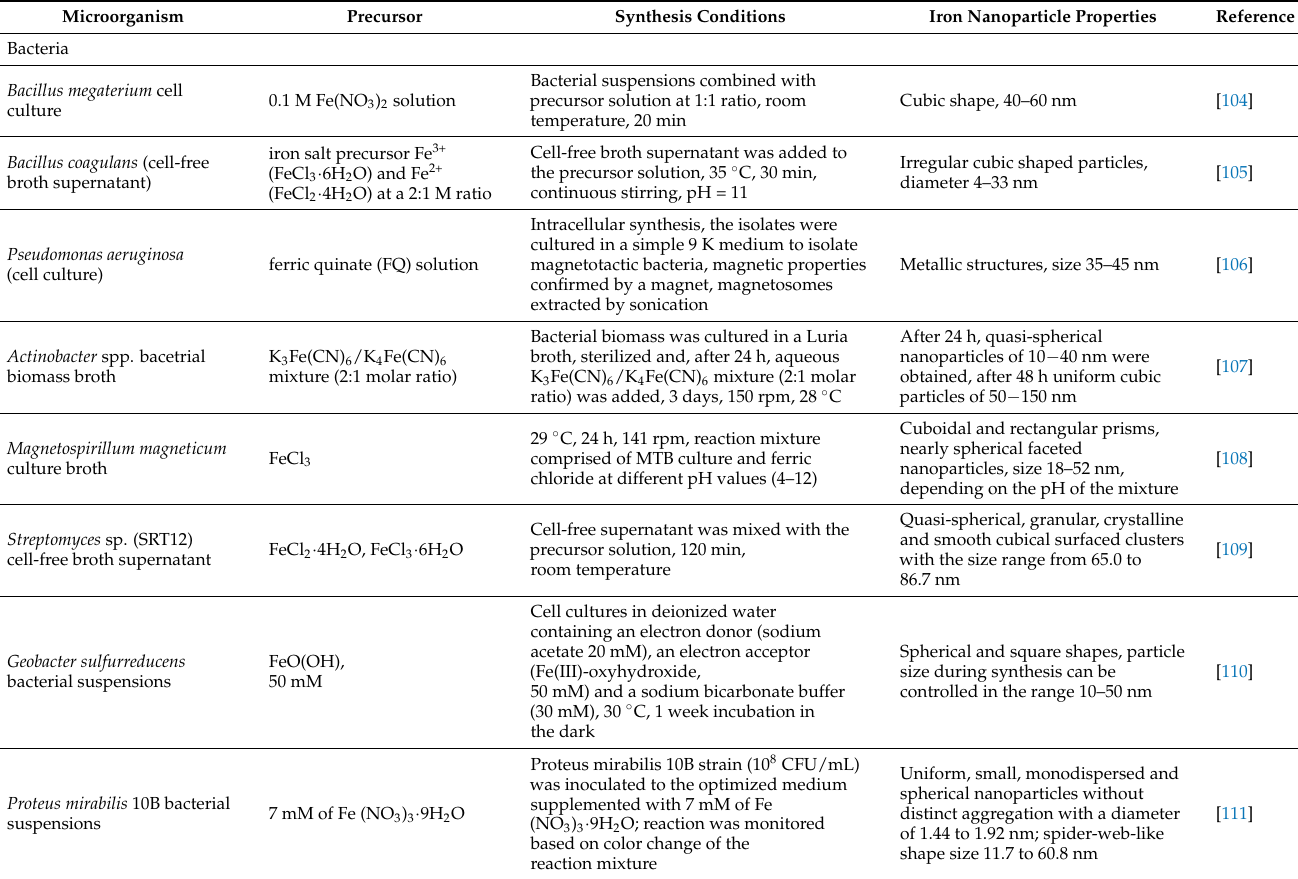
Table 3. Some examples of use of bacteria and fungi for synthesis of iron